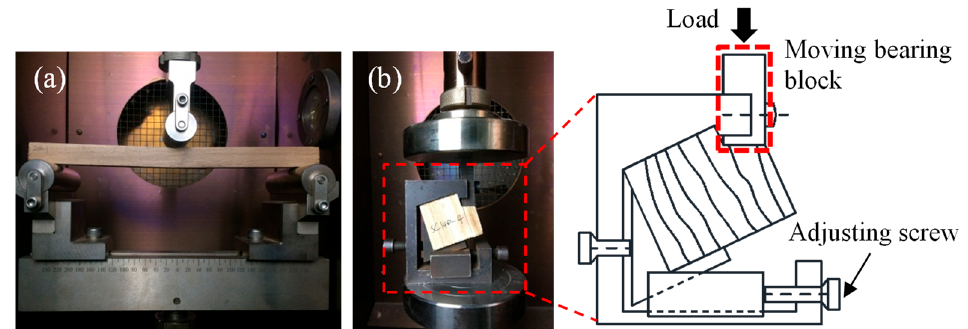
Figure 2. Experimental set-up: ( a ) three-point bending; ( b )